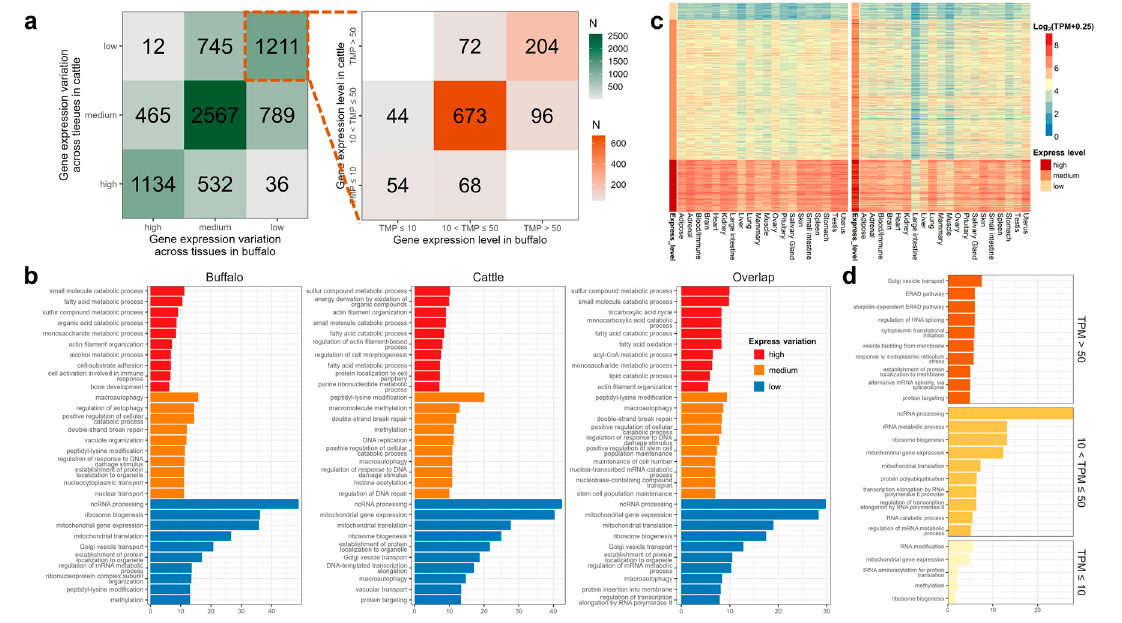
Figure 4. Comparison of housekeeping genes. ( a ) The number of low, moderate, and high expression variability HKGs ( left ), and the number of the low (TMP ≤ 10), medium (10 < TPM ≤ 50), and high (TMP > 50) expression levels of HKGs with low expression variability. ( b ) The GO enrichment of preliminarily screened HKGs. ( c ) Heatmap of gene expression of low ‐ variable HKGs in buffalo ( left ) and cattle ( right ). ( d ) GO enrichment of overlapped low ‐ variable HKGs.